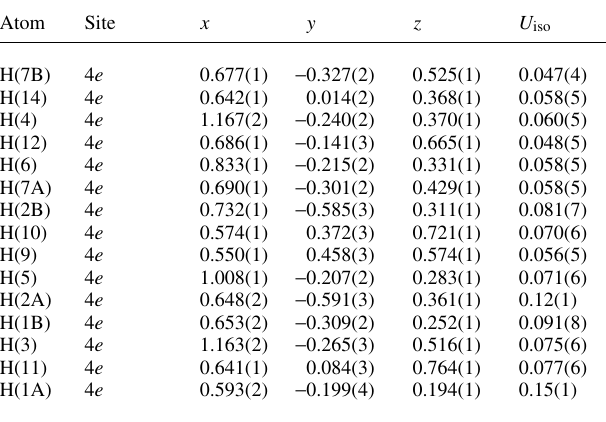
Table 2. Atomic coordinates and displacement parameters (in Å 2 ) .